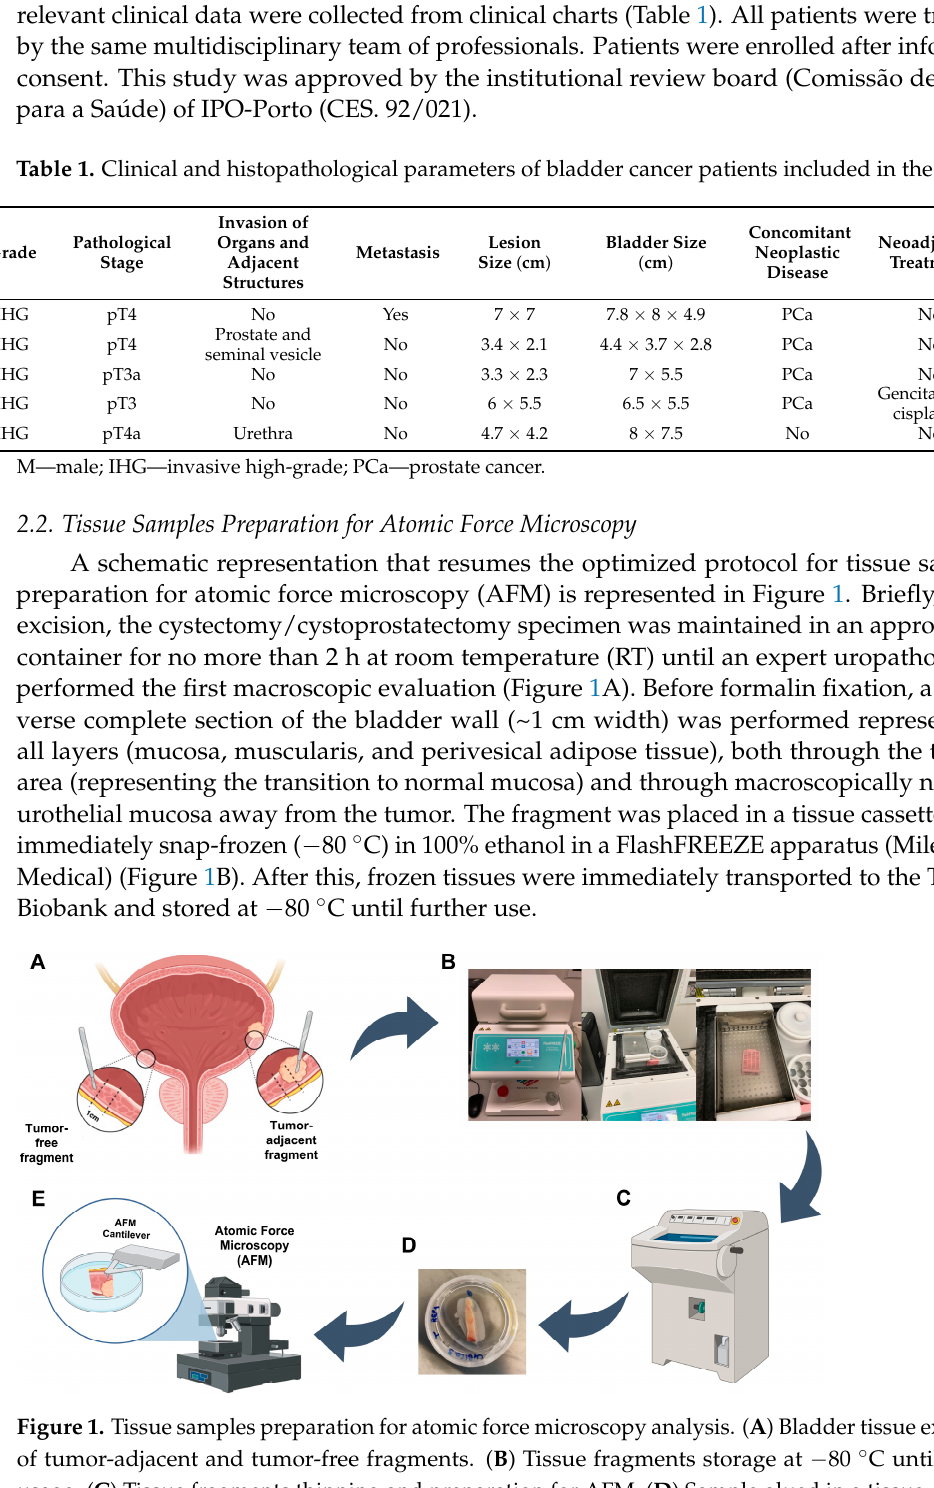
Table 1. Clinical and histopathological parameters of bladder cancer patients included in the study.